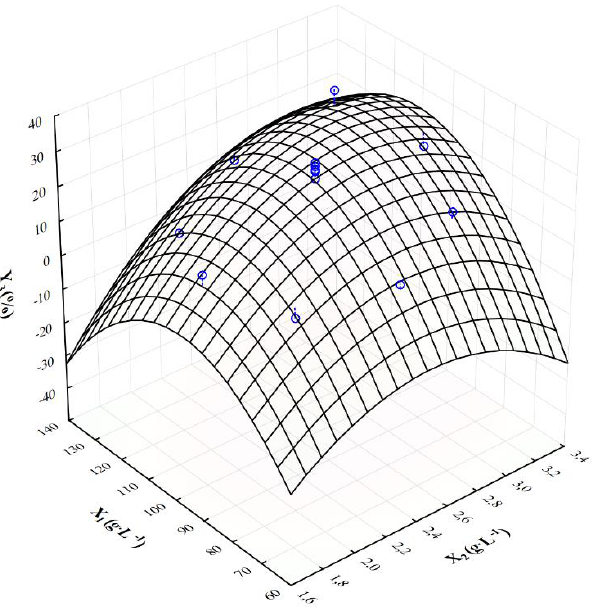
Figure 3. Response surface plot (3D) of the influence of the crude glycerol concentration (X 1 ) and ammonium nitrate concentration (X 2 ) on the yield of citric acid biosynthesis (Y 3 ); blue points—points where the measurement was made